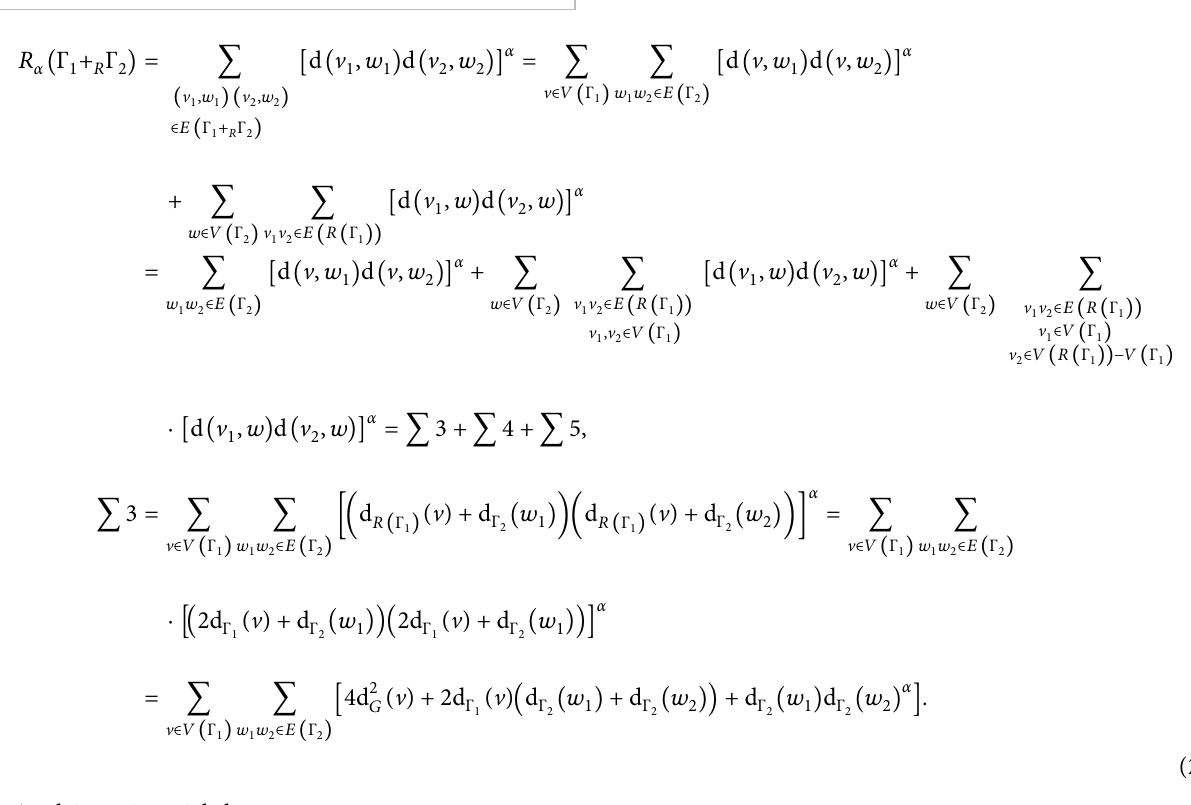
Table 2: Edge partition based upon degree of end vertices of graph P